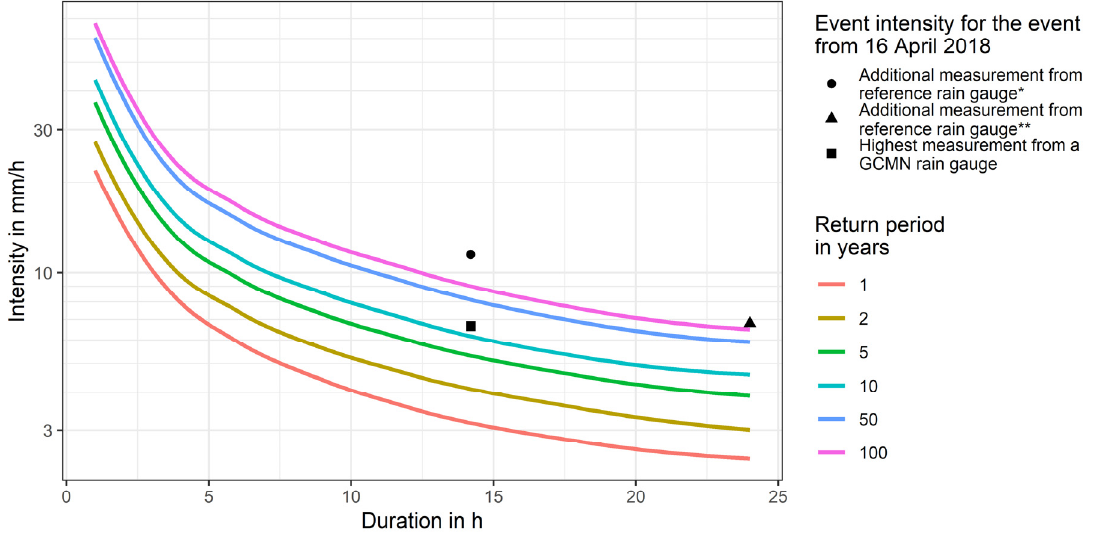
Figure 5. Relevant intensity-duration-frequency (IDF) curves for infrastructure management and design processes for the location of the dataset’s origin (data from Styrian Federal State Department for Hydrographical Observations [53]). * assuming the event duration of 14.2 h evaluated from the 16 rain gauges from the GCMN; ** using the measured daily intensity.